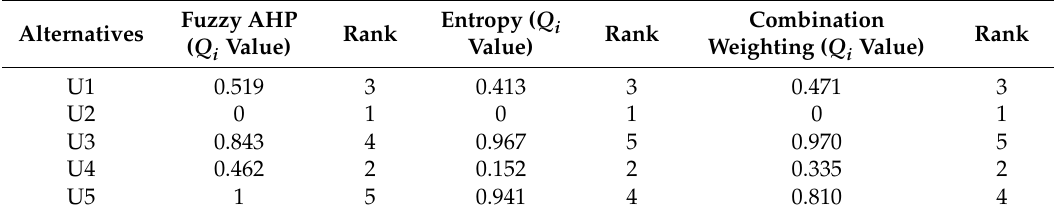
Table 24. The performance ranks of five alternatives using different weighting